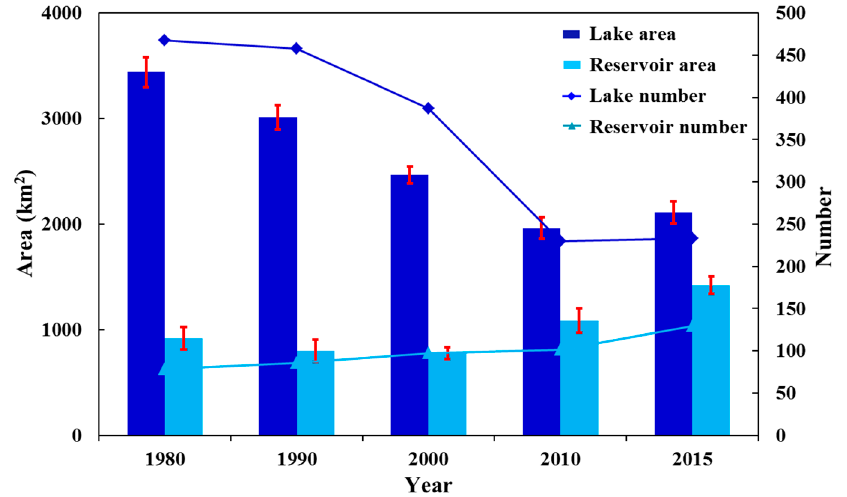
Figure 5. Decadal variations in the total area and number of lakes and reservoirs (area ≥ 1 km 2 ) in the NJW from 1980 to 2015. The error bars represent the 95% confidence level.